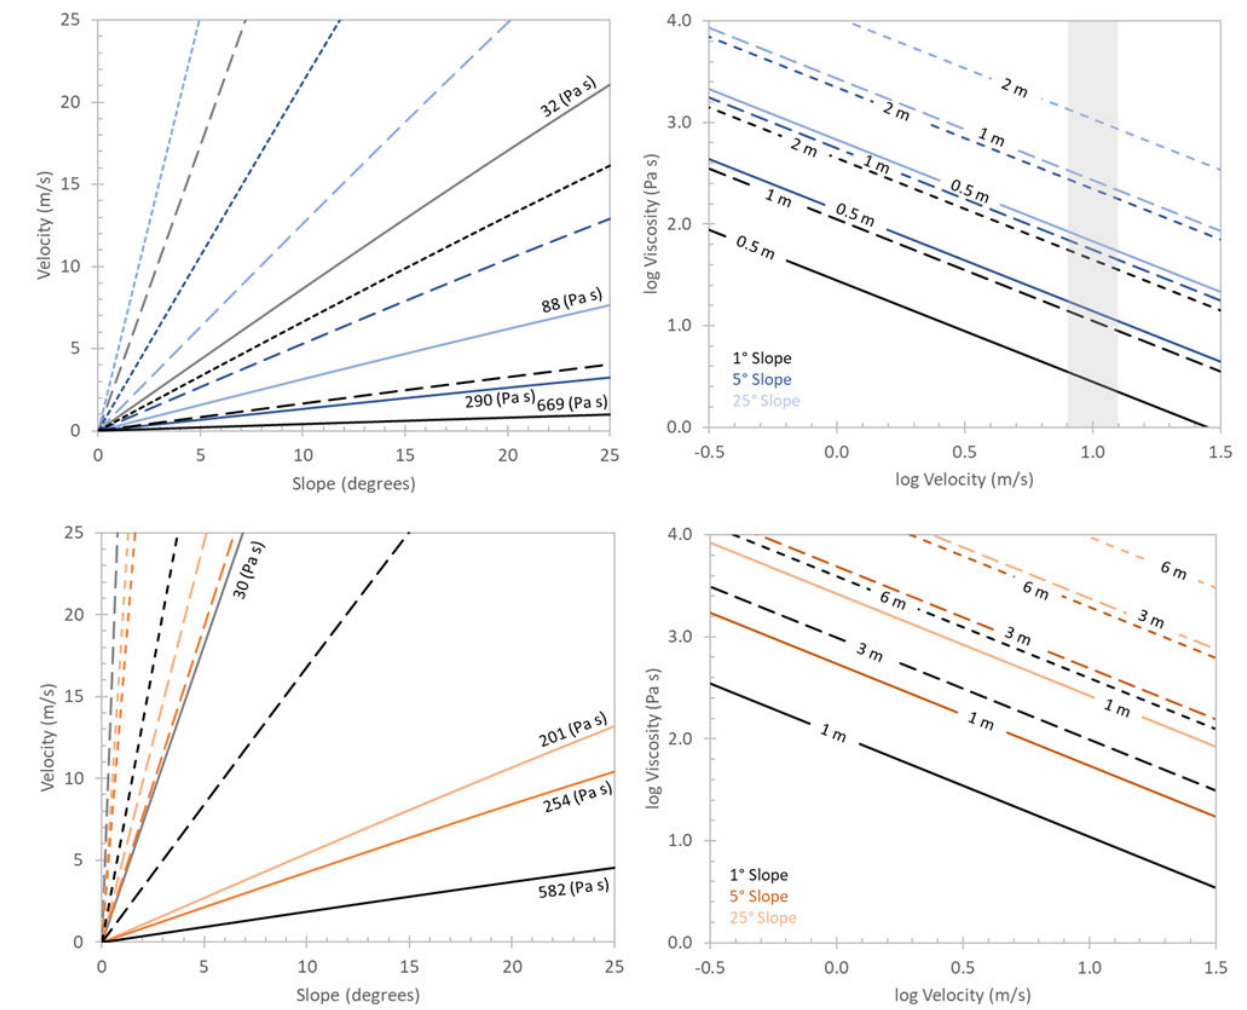
Figure 12: Comparison of flow velocities for Nyiragongo (top) and Nyamuragira (bottom) flows as a function of viscosity and slope. Velocities have been estimated using Je ff reys’ equation (Equation 11). Newtonian viscosities used were taken from Table 2 and channel depths were estimated from field observations made during sample collection. Three di ff erent channel depths were used for each composition. NYI: 0.5 m (solid lines), 1 m (long- dashed lines), and 2 m (short-dashed lines); NYA: 1 m (solid lines), 3 m (long-dashed lines), and 6 m (short-dashed lines). Colors represent the same viscosity for each channel depth with the solid lines labeled. The gray bar (top right) represents the estimated velocities from eye witness accounts of the Nyiragongo flows which are similar to the velocities reported for Hawaiian